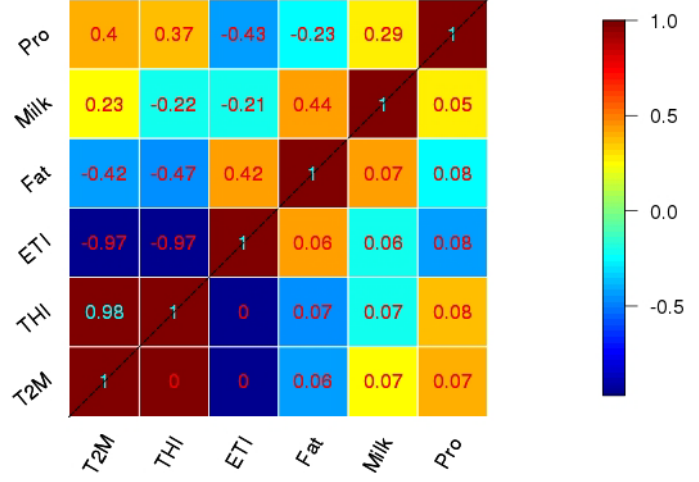
Figure 5. Correlation (above diagonal) and respective interquartile range of bootstrap sample (below diagonal) between milk compounds and climatic indices in